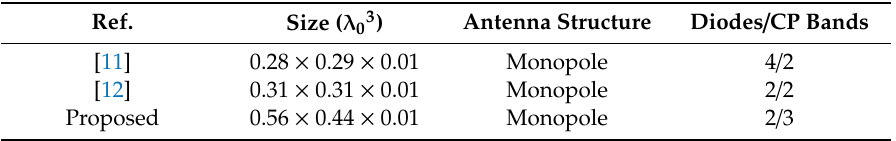
Table 3. Performance comparison with other bi-directional multi-band reconfigurable CP antennas.